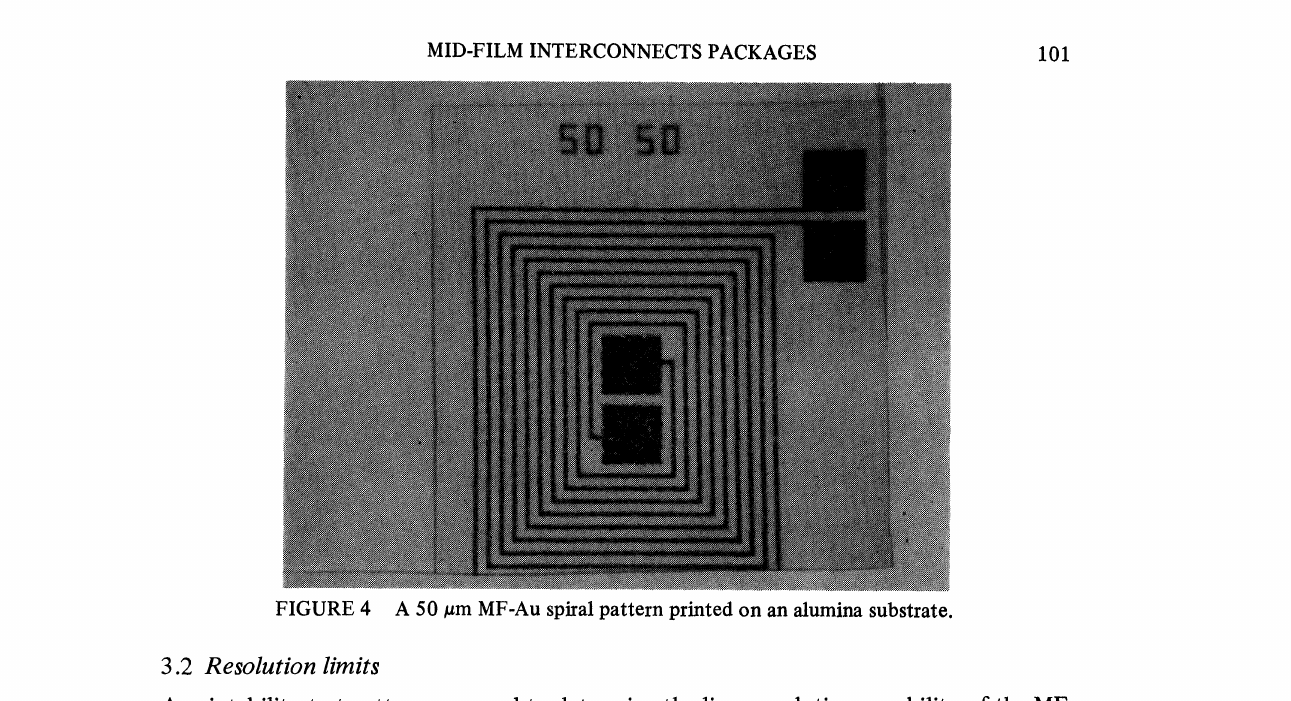
FIGURE 4 A 50 vm MF-Au spiral pattern printed on an alumina substrate.